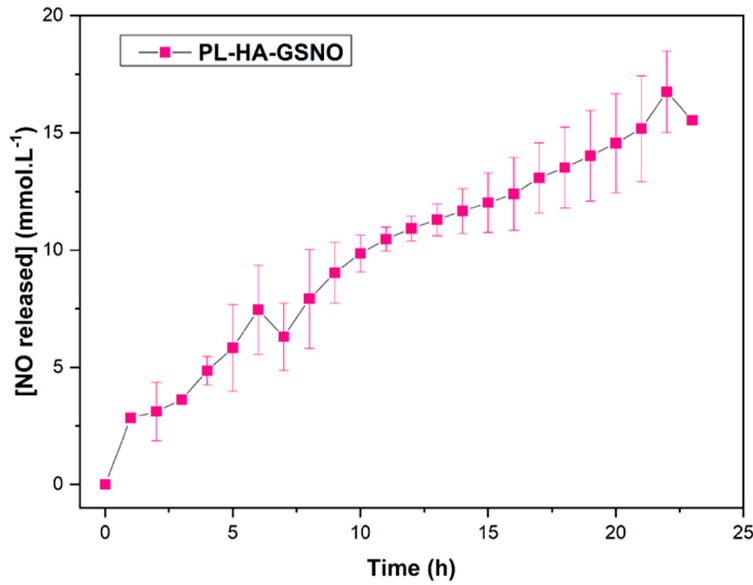
Figure 5. Kinetics of NO release from PL-HA-GSNO hydrogel (initial GSNO concentration 25 mmol·L − 1 ) at 37 °C, monitored for 24 h. The results are reported as the mean ± standard deviation of two independent experiments.